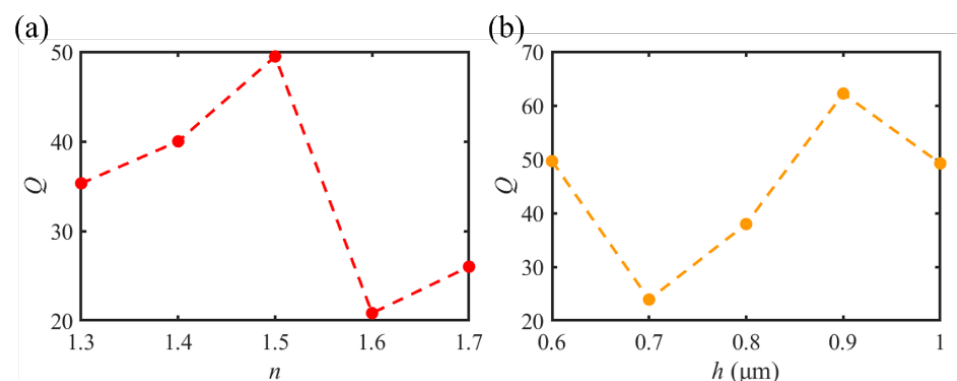
Figure 11. Quality factor Q for ( a ) different dielectric microdisk thickness n and ( b ) different dielectric microdisk refractive index h .